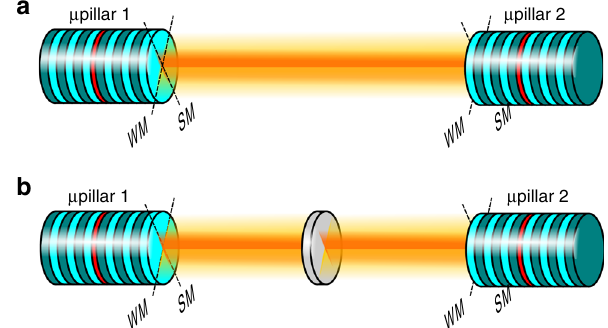
Fig. 1 Illustration of the studied experimental con fi gurations. a Face-to-face mutual coupling and b mutual coupling via passive relay of two micropillar ( μ pillar) lasers. The setup is arranged to couple the two perpendicularly polarized emission modes of each micropillar (i.e. strong mode (SM) and weak mode (WM)) to their respective